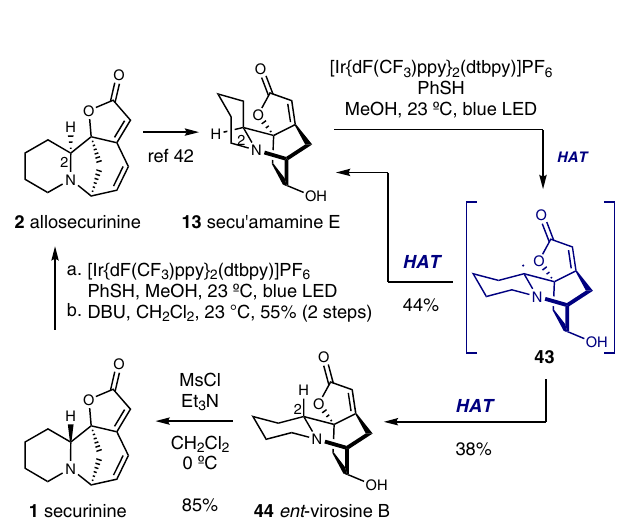
Fig. 6 | Total synthesis of 4-epi-phyllanthine (4) via hydrogen atom transfer (HAT)-based C2-epimerization of the neosecurinine scaffold. a Ellman ’ s light- mediated piperidine epimerization (ref. 41); b Light-mediated C2-epimerization of